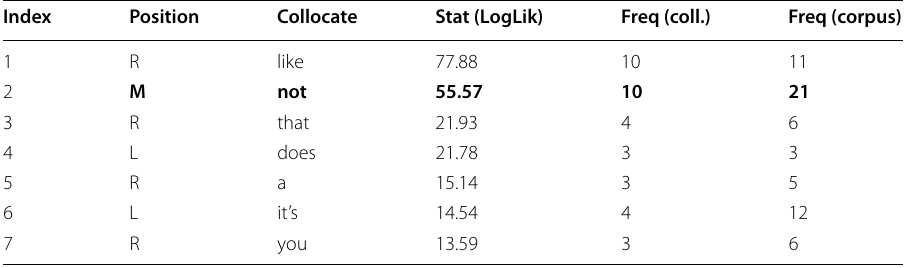
Table 3 Collocates of the search term look|looks|looked in Easson Corpus of Transferred Negation (06—LogLik (6.63), L5-R5, C: 3.0-NC: 3.0; no filter